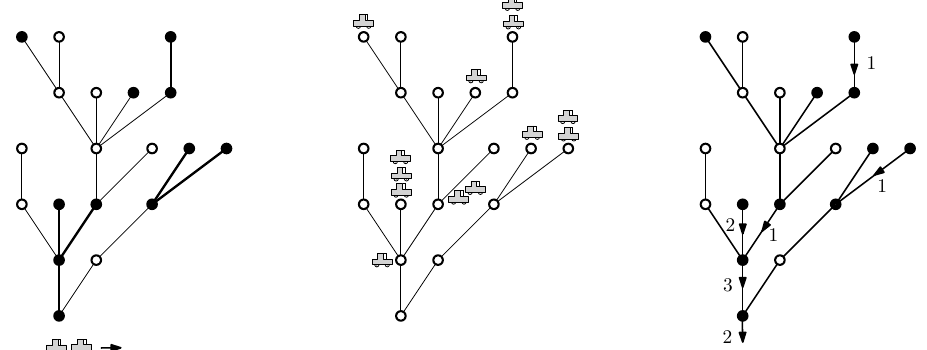
Figure 1: Middle: A plane tree together with a configuration of cars trying to park. Left: the resulting parking configuration, where 2 cars did not manage to park on the tree. Right: the same parked tree with flux on the edges (all the non-labeled edges have flux